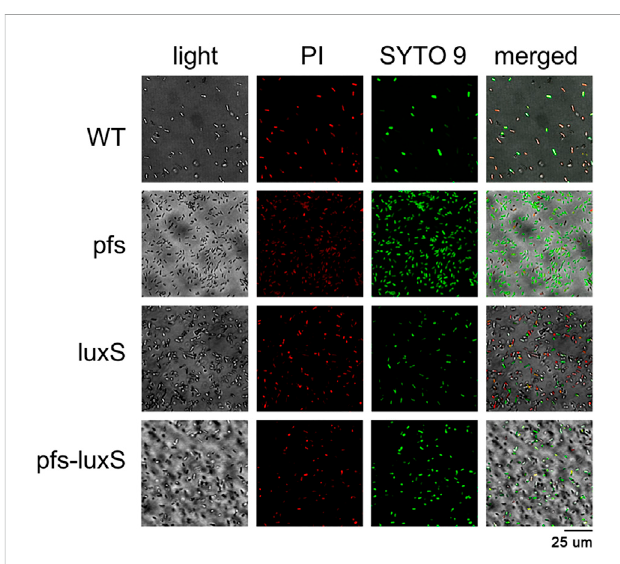
FIGURE 6 Images of WT, ZM4:pfs, ZM4:luxS, ZM4:pfs-luxS after 2.1 g/L acetic acid shock. SYTO 9 stain and propidium iodide were used to stain cells. Live cells fl uoresced green and dead cells fl uoresced